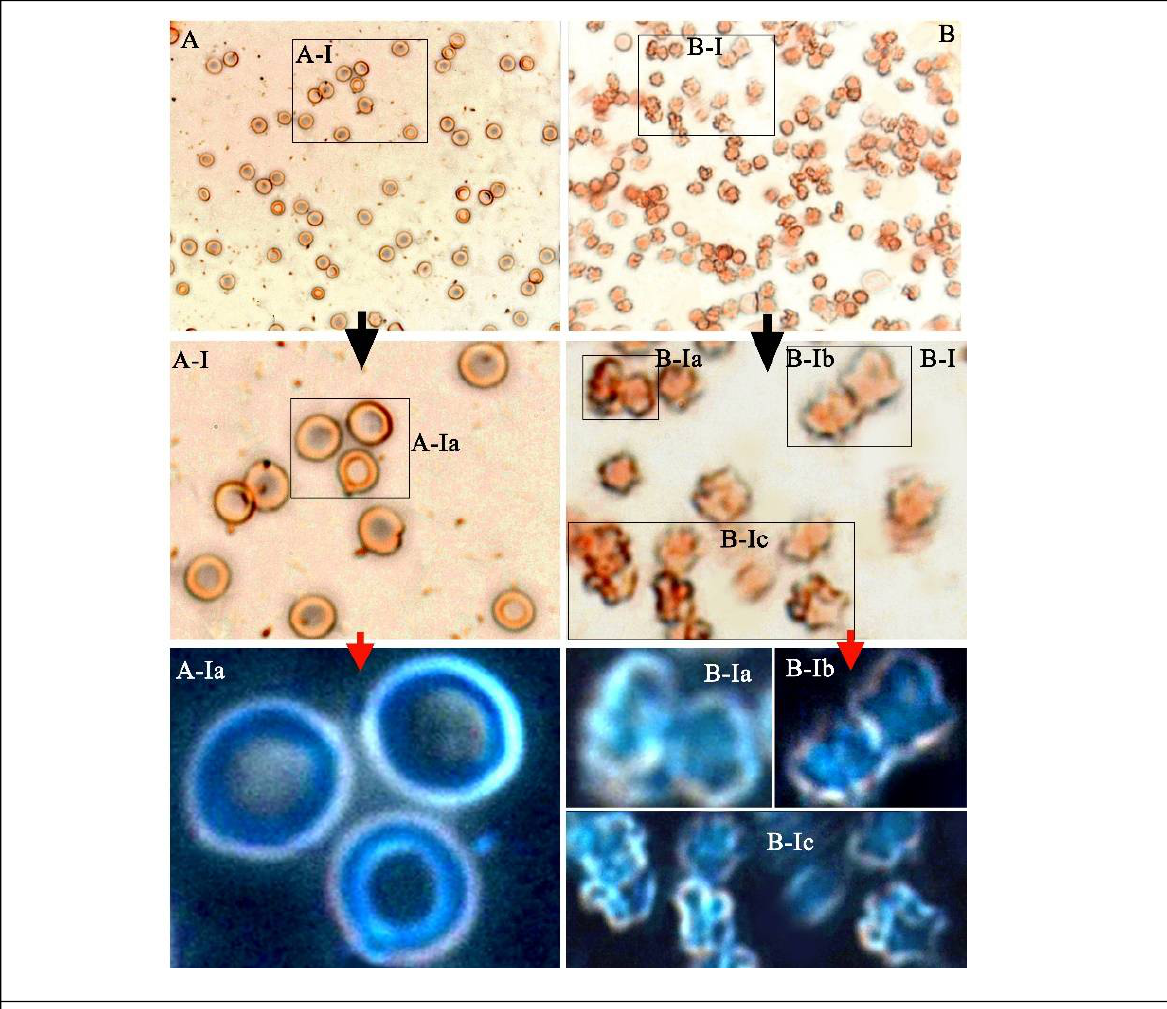
Figure 1: Acute exposure to cigarette smoke deforms erythrocyte morphology. Under the microscope: (A) smoke-unexposed control erythrocytes; and (B) cigarette smoke-exposed erythrocytes (100X